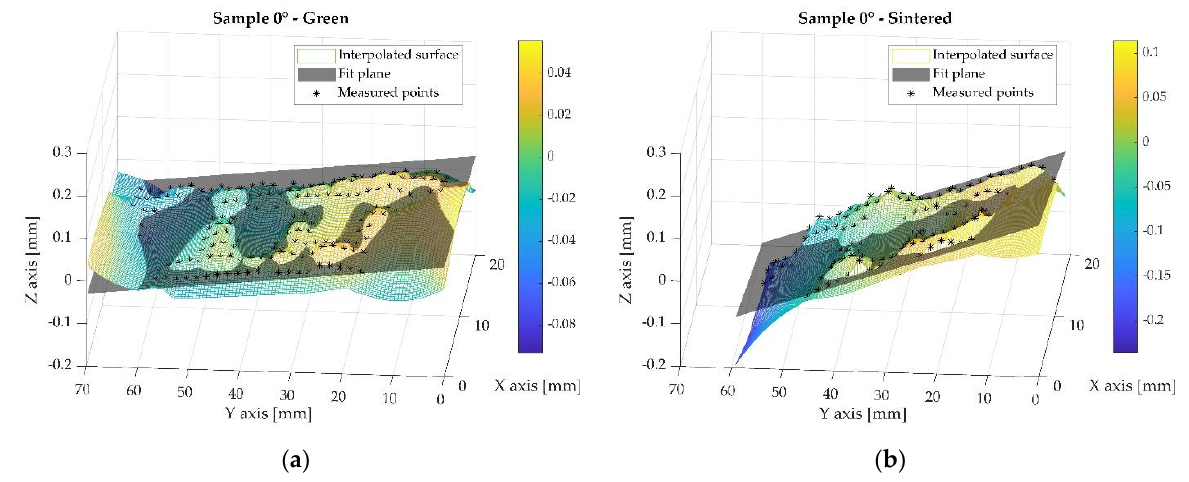
Figure 7. Sample 0°: ( a ) points measured at the green state and reconstruction of the plane; ( b ) points measured at the sintered state and reconstruction of the plane.